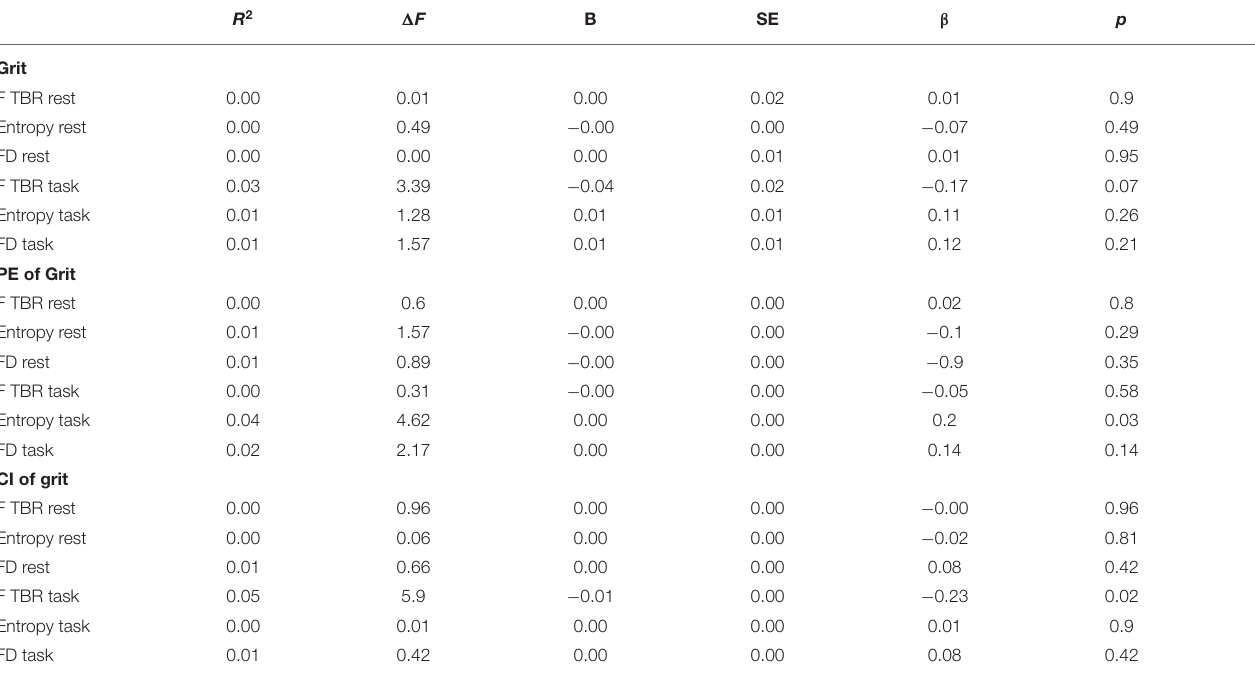
TABLE 3 | Hierarchical regression analyses of grit and its two factors over neural indices (frontal TBR, entropy, and FD) during rest and during the task controlling for impulsiveness. R 2 1